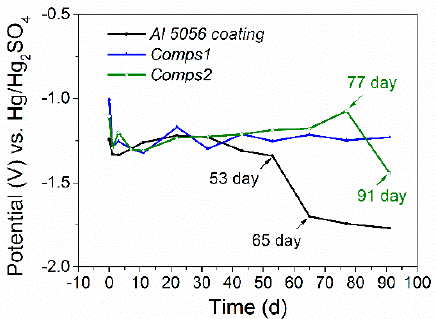
Figure 8. Open circuit potential (OCP) evolution of the cold-sprayed Al 5056 coating and SiC p / Al 5056 composite coatings on the magnesium substrate for an immersion period of 91 days.